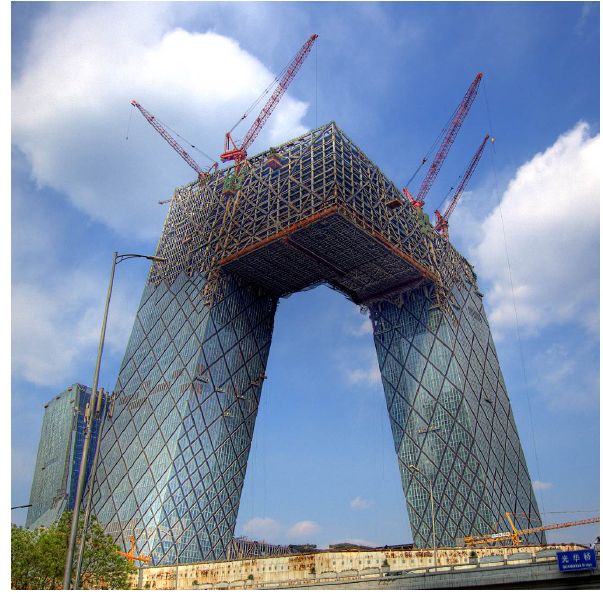
Figure 9. CCTV Headquarters (courtesy of Jakob Montrasio,